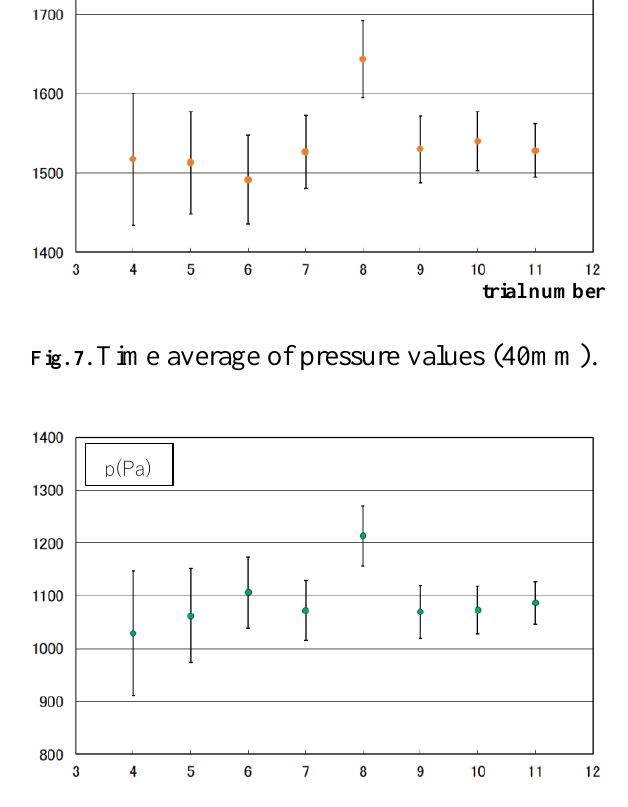
Fig. 8. Time average of pressure values (80mm).